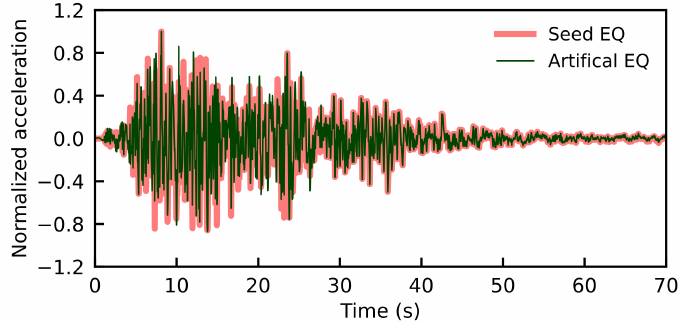
Figure 17. The normalized artificial earthquake and seed